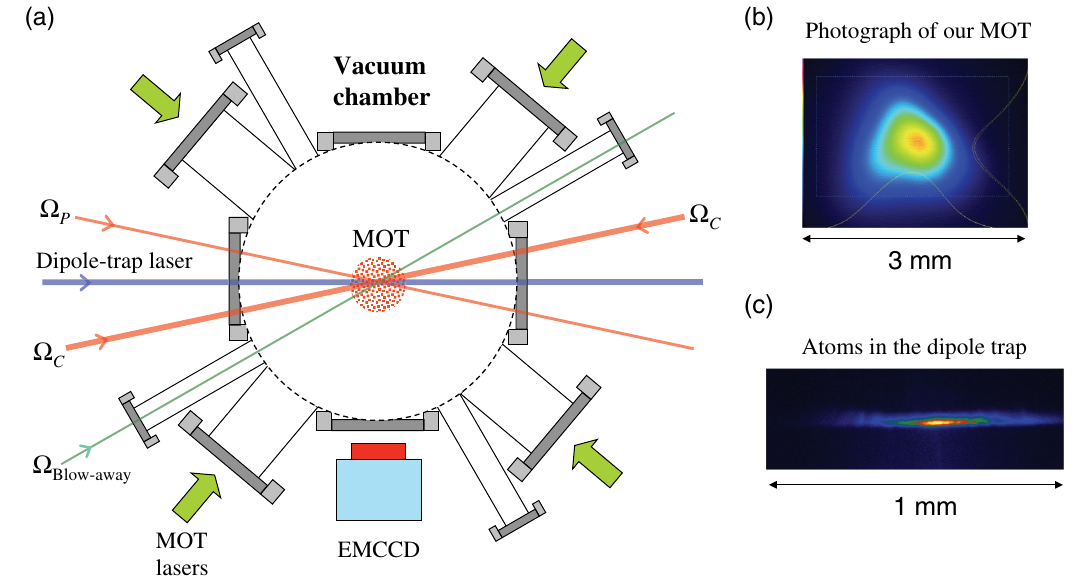
FIG. 2. (a) The top view of our ultrahigh vacuum chamber. The probe and the coupling laser beams propagate at a slight angle to the dipole-trapping beam direction. The coupling laser standing wave is formed using a counterpropagating beam pair. The blow-away beam, (cid:2) blow - away , removes from the trap the atoms that have been transferred to the F ¼ 2 level. This beam is required for the localization measurement protocol as described in the text. (b) A photograph of the atoms trapped in the MOT. (c) The fluorescence image of the atoms trapped in the dipole